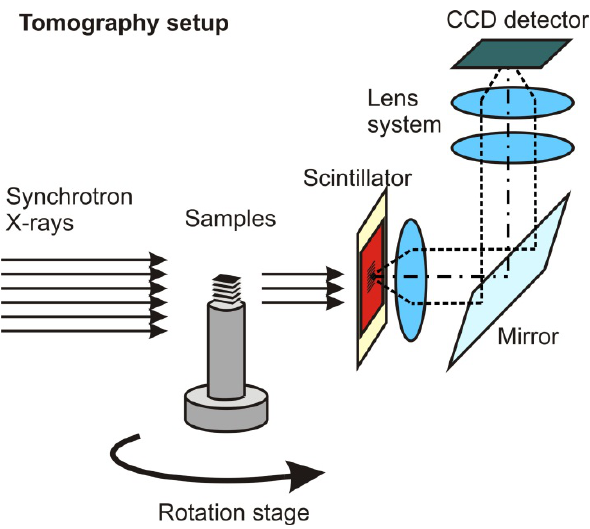
Figure 7. Setup used for synchrotron